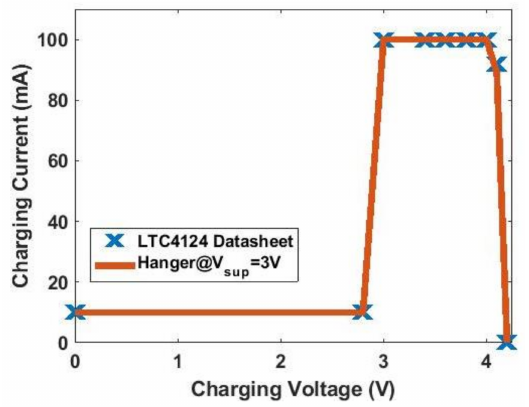
Figure 23. Wireless-charging hanger test with